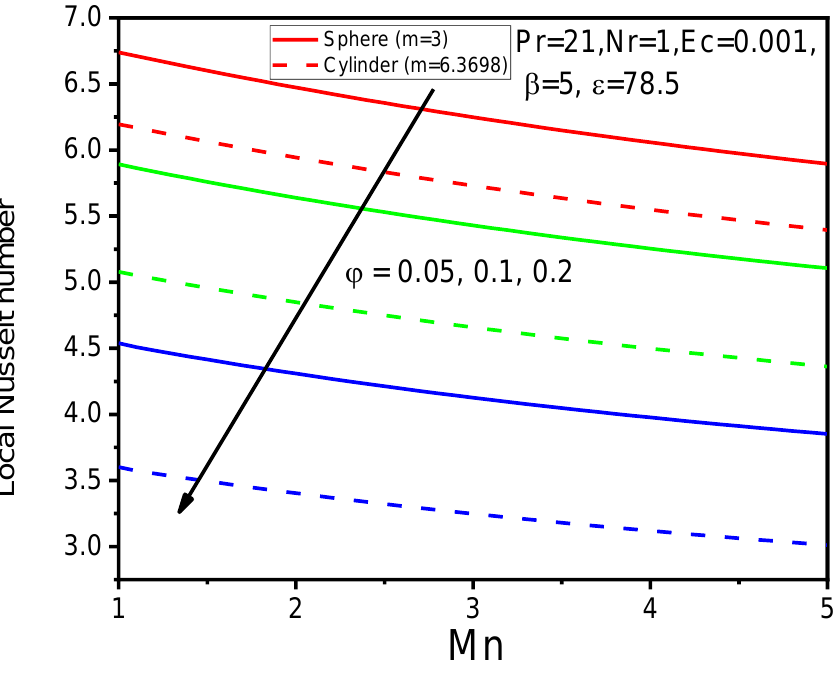
Figure 21. (Case b): Values of the skin friction coefficient for different values of φ against Mn .